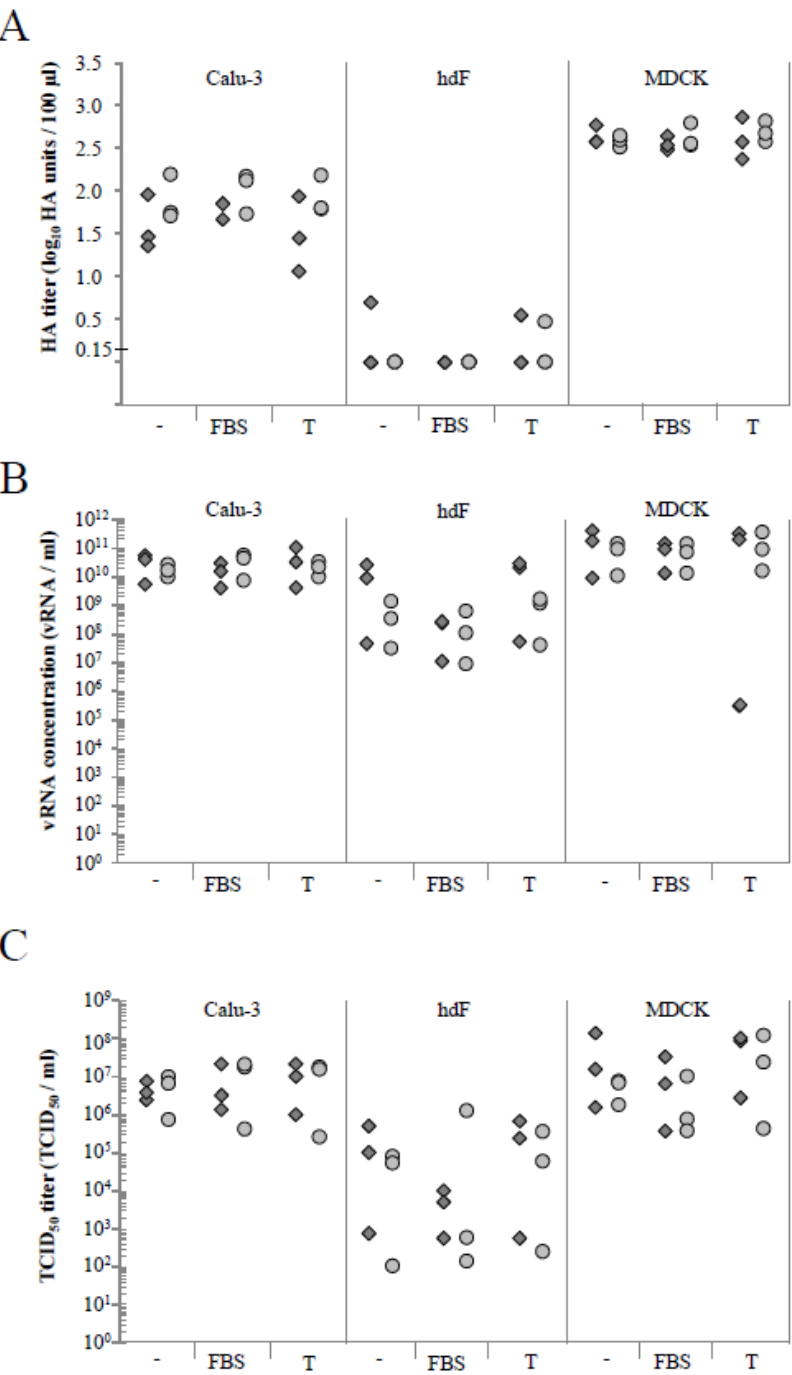
Figure 4. Comparison of virus replication of A/PR/8/34 and NS1-RFP influenza A virus (IAV) in Calu-3 cells, hpF, and MDCK cells under different medium conditions. Data show the respective titer at 24 h post infection (hpi) for Calu-3 cells, hpF, and MDCK cells cultured in two-dimension (2D) (6 well plates) and infected at a multiplicity of infection (MOI) of 1 with A/PR/8/34 or NS1-RFP viruses in basal medium (-), with fetal bovine serum (FBS) or with trypsin (T). ( A ) HA assay (detection limit of 0.15 log 10 (HA units/100 µL)), ( B ) RT-qPCR, and ( C ) TCID 50 assay. Shown are the values of each of the three independent experiments. Light grey circle = A/PR/8/34 virus; dark grey square = NS1-RFP virus; hpF = human primary fibroblasts.